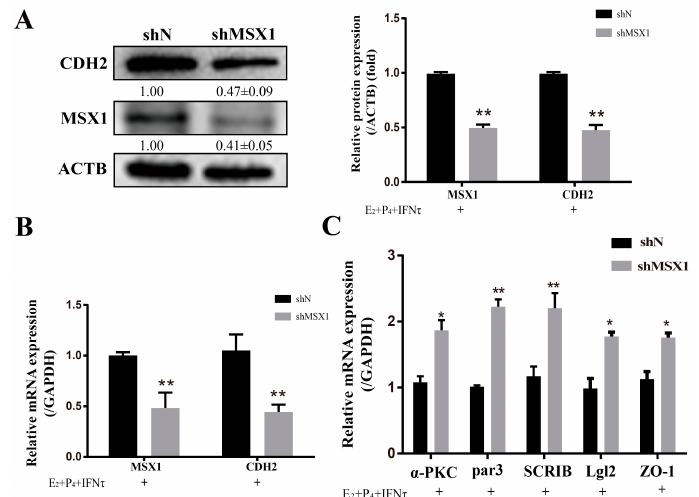
Figure 5. Knockdown of MSX1 hindered the PMT induced by hormones. ( A ) Western blot and analysis results of CDH1 and MSX1 expression in the shN group and shMSX1 group; ( B ) mRNA expression levels of CDH2 and MSX1 ; ( C ) mRNA expression levels of ZO-1 , α -PKC , Par3 , SCRIB, and Lgl2 . * p < 0.05; ** p < 0.01.